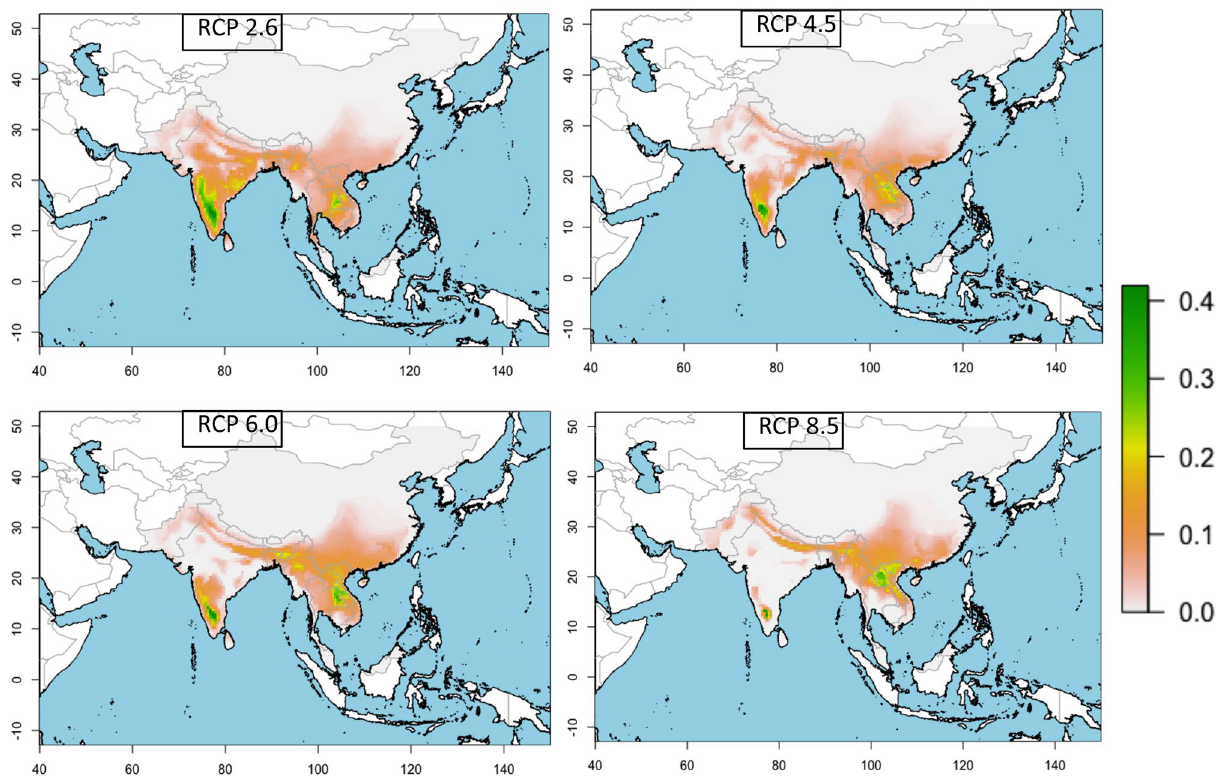
Figure 2. The consensus map of the future (in the year of 2070) suitable climatic niche of Naja naja in four different RCPs trajectories. The largest suitable climatic space is in RCP 2.6 and the least is in RCP 8.5. The maps were generated from spatial polygon data frame of wrld_simpl function of maptools 64 r-package.